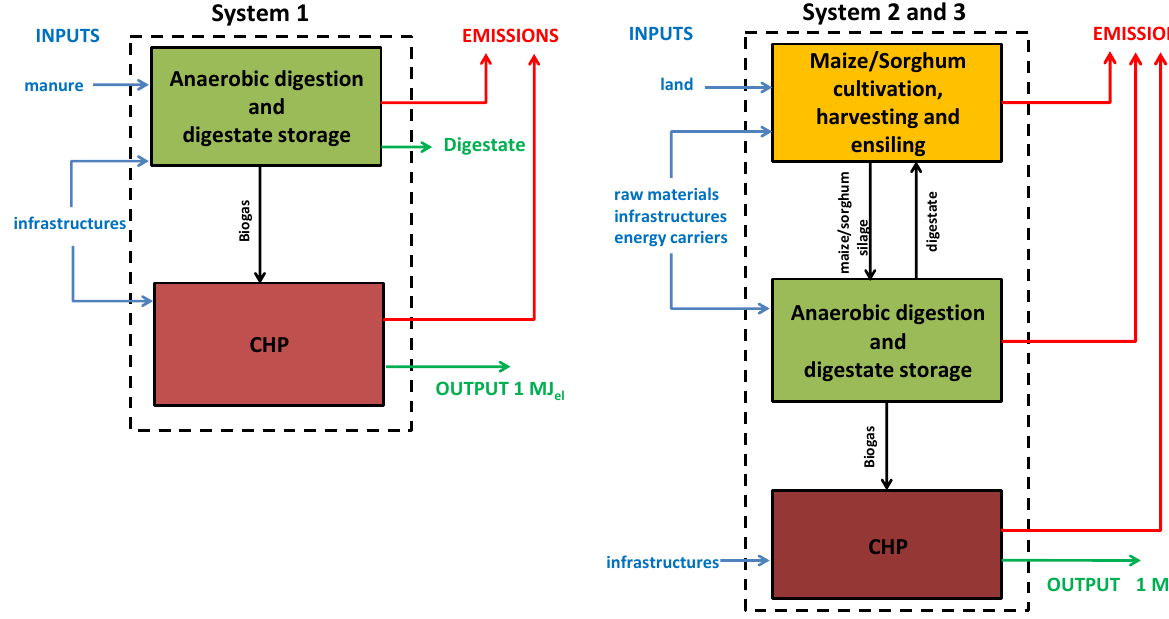
Figure 1. System boundaries considered in the study for biogas production from manure (System 1) and from energy crops (Systems 2 and